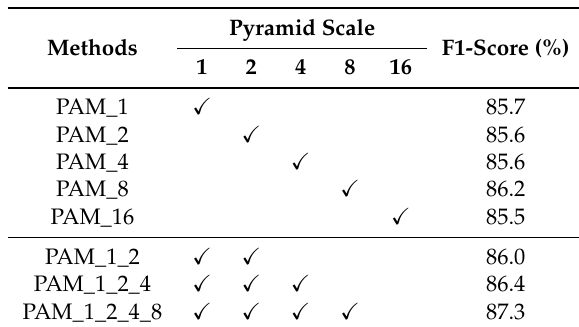
Table 8. Comparisons between different combinations of several pyramid partition scales in PAM on the LEVIR-CD test